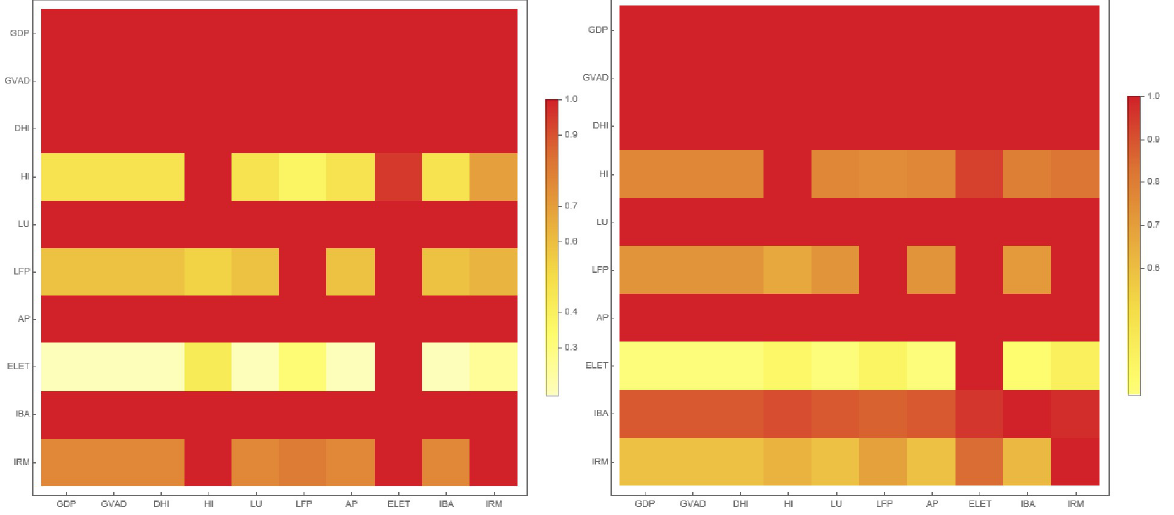
Fig 4. Conditional probabilities of links within each layer for Central and Eastern Europe regions (left hand side) and Western Europe regions (right hand